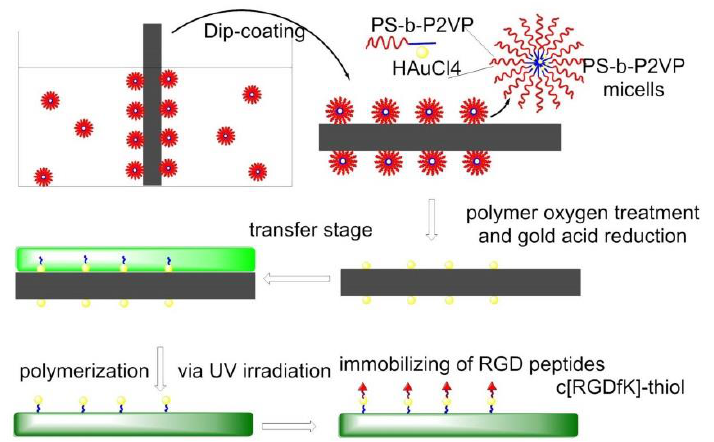
Figure 12. Nanolithography surfaces functionalization. PS-b-P2VP micelles were dip-coated on glass, forming Au-nanopatterned surfaces. c[RGDfK]-thiol was anchored on gold before cell